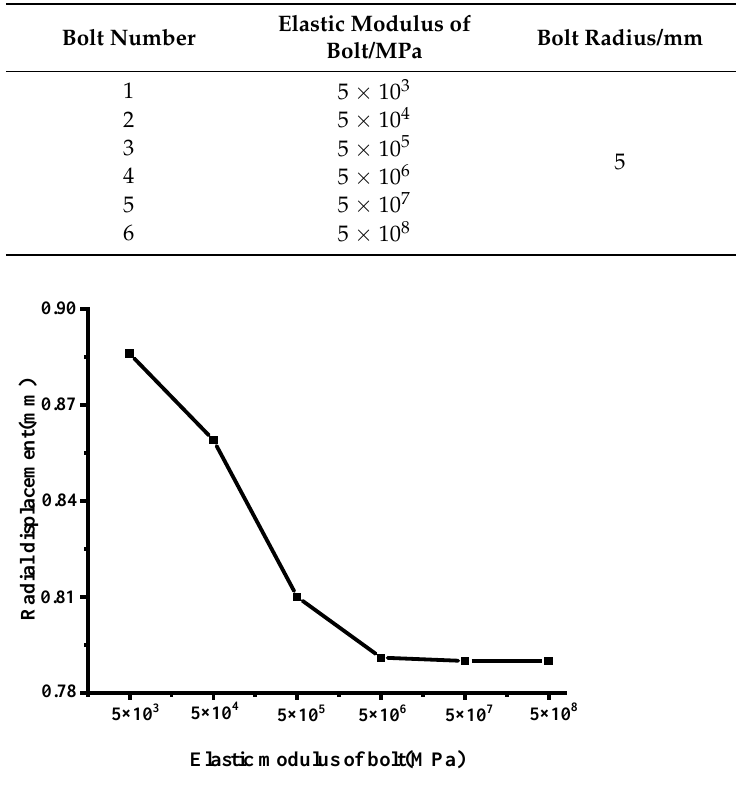
Figure 12. Relationship between bolt elastic modulus and u r .